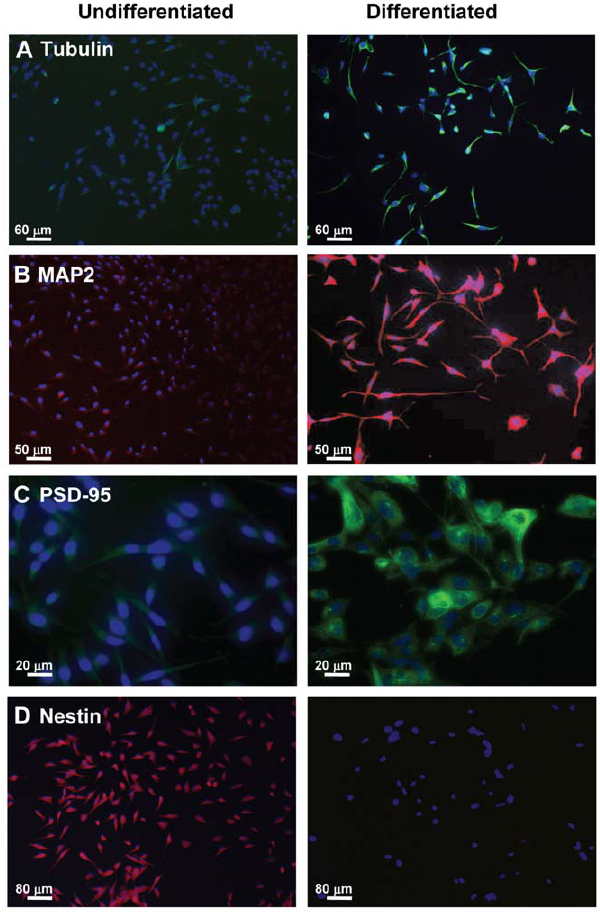
Figure 3. Expression pattern of mature neuron markers acetylat- ed tubulin, MAP2 and PSD-95 and stem cell marker nestin in undifferentiated and differentiated HiB5 cells. Specific markers were detected using primary antibodies and immunofluorescence detection with DAPI as nuclear counter stain. Detectable levels of IF were associated with, acetylated tubulin ( A ); MAP2 ( B ); PSD-95 in differentiated HiB5 cells ( C ), while nestin ( D ) is only seen in undifferentiated cells.